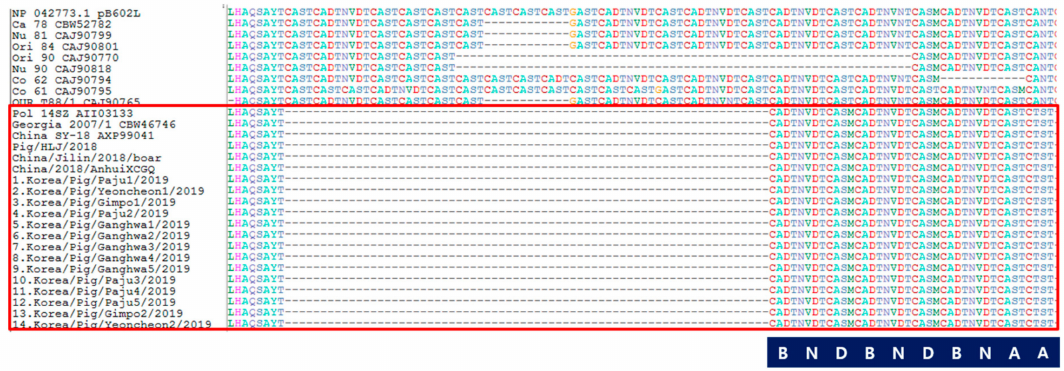
Figure 3. Central hypervariable region (CVR) analysis of ASFV isolated in domestic pigs of South Korea, 2019. Code as labeled in previous studies; [6]. A = CAST, CVST, CTST, or CASI; B = CADT, CADI, CTDT, or CAGT; D = CASM; N = NVDT, NVGT, NVDI, or